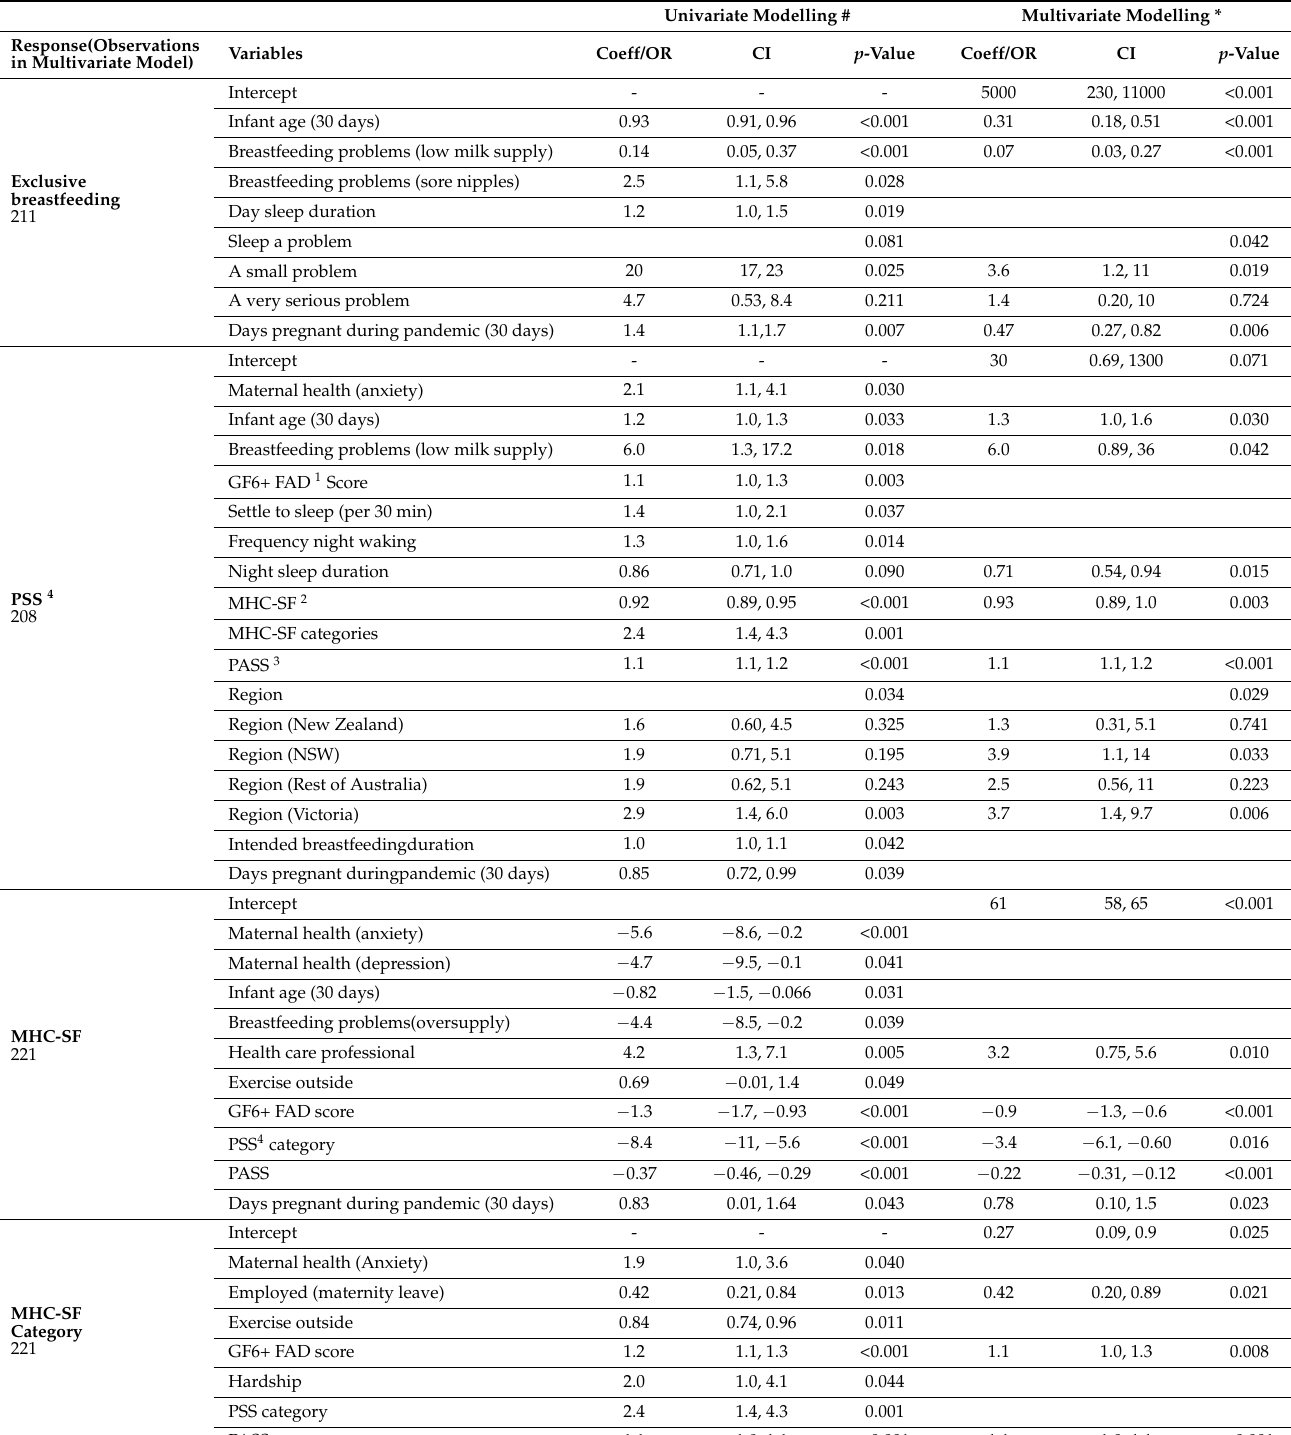
Table 4. Univariate model and multivariate models for exclusive breastfeeding, PSS score, MSH score, and category, and PASS